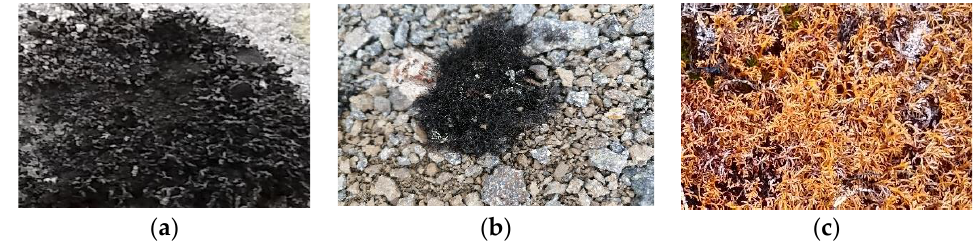
Figure 1. Lichens thallus in the polar tundra of King George Island, Maritime Antarctic ( a ) Lecania brialmontii ; ( b ) Pseudephebe pubescens ; ( c ) Sphaerophorus globosus .